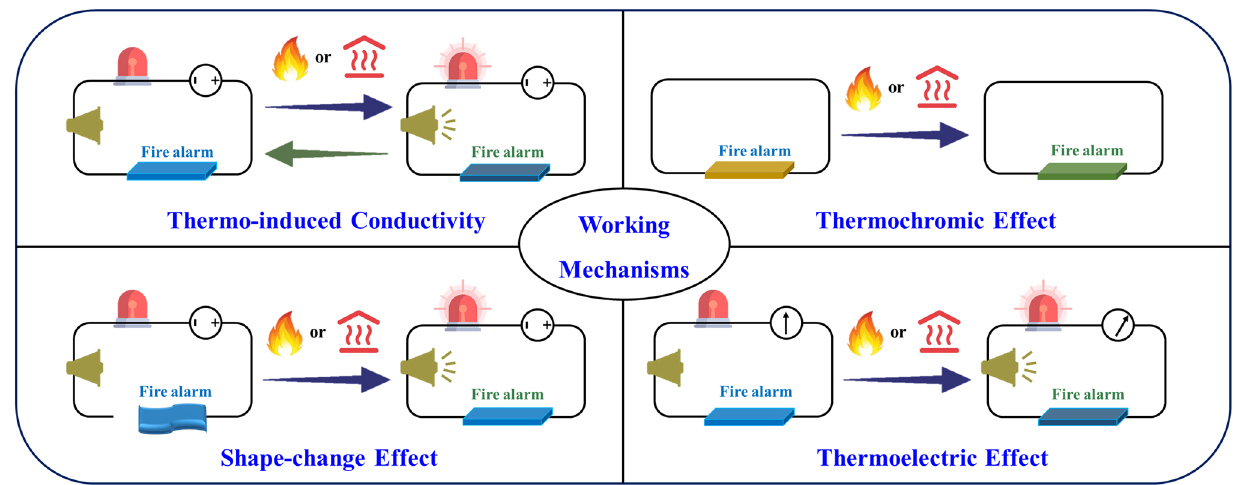
Scheme 1 Schematic illustration of the different working mechanisms of